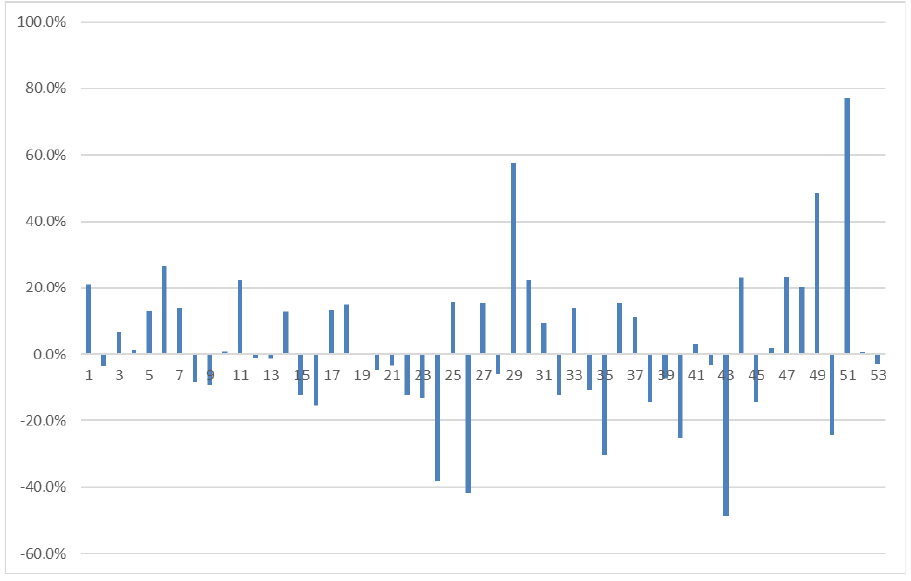
Figure 12. Dynamics of changes in the price of LW Bogdanka S.A. shares.